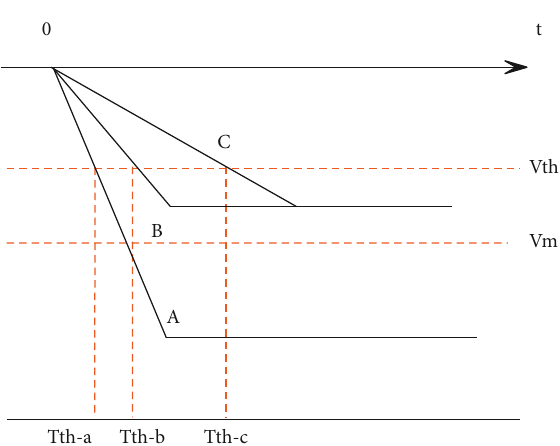
Figure 2: Amplitude walk effect and rise time walk